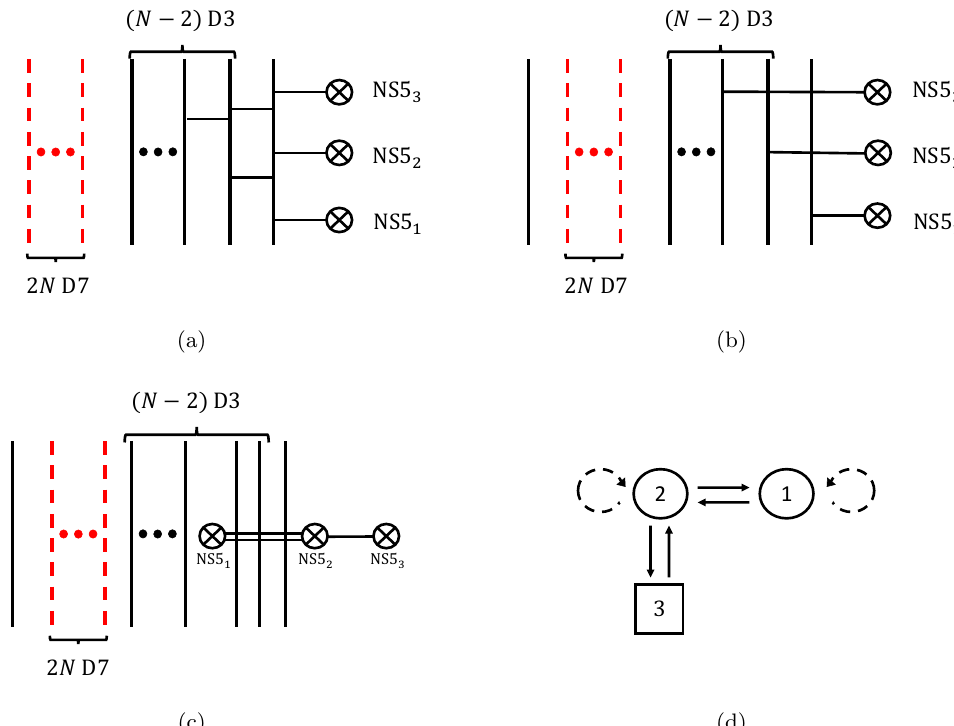
Figure 13 . (a) An introduction of smooth monopoles to (cid:12)gure 10. (b) We adjust the positions of the D1-branes to realize the screening sector v = e N (cid:0) 2 + e N (cid:0) 1 + e N . (c) The brane con(cid:12)guration that allows us to read o(cid:11) the SQM for the sector. (d) The corresponding quiver